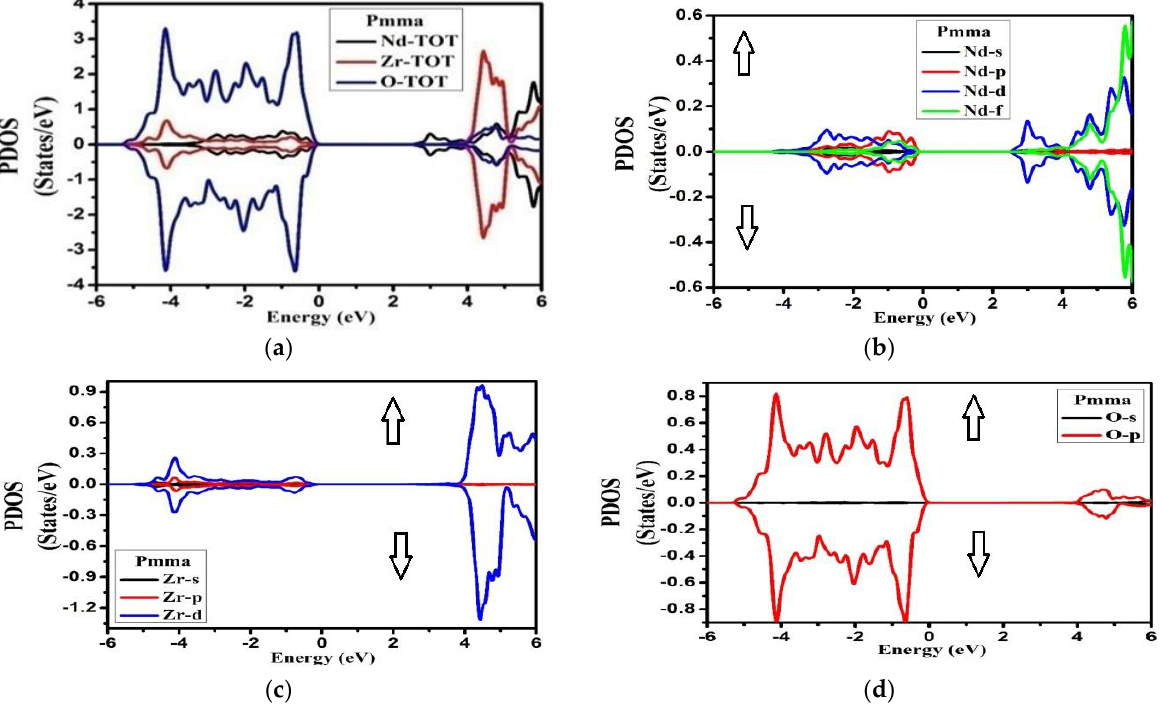
Figure 6. Partial density of states ( a ) Nd-TOT, Zr-TOT, O-TOT; ( b ) Nd-s,p,d,f; ( c ) Zr-s,p,d; ( d ) O-s,p for Nd 2 Zr 2 O 7 in the Pmma phase for the spin-up direction ( ↑ ) and spin-down ( ↓ ) direction.